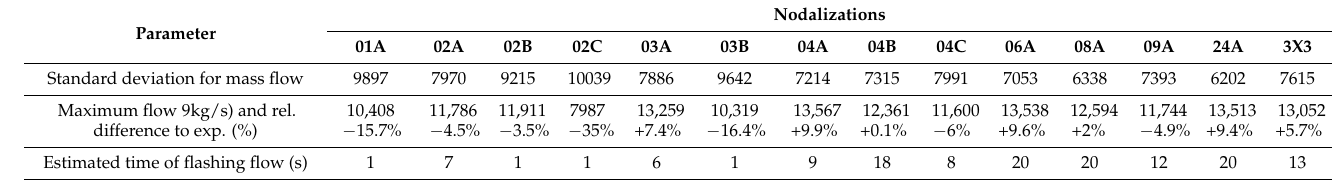
Table 4. Standard deviations for the default calculations using different nodalizations. Experimental maximum flow of 12,347 kg/s. Experimental time of the flashing flow of ~30